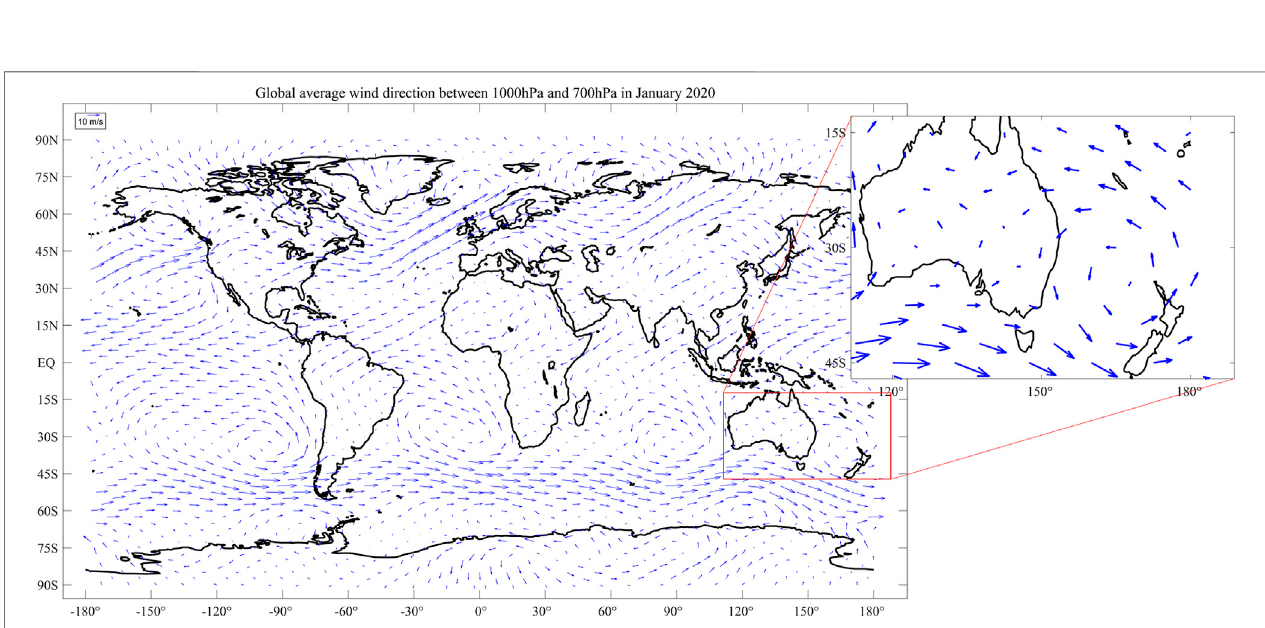
Frontiers in Earth Science |